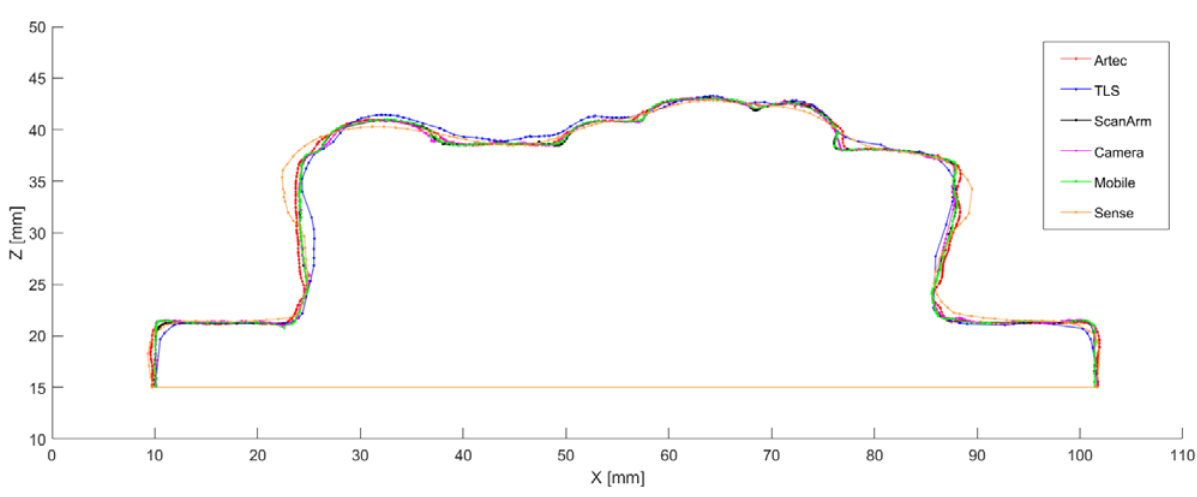
Figure 6. Model contours in a